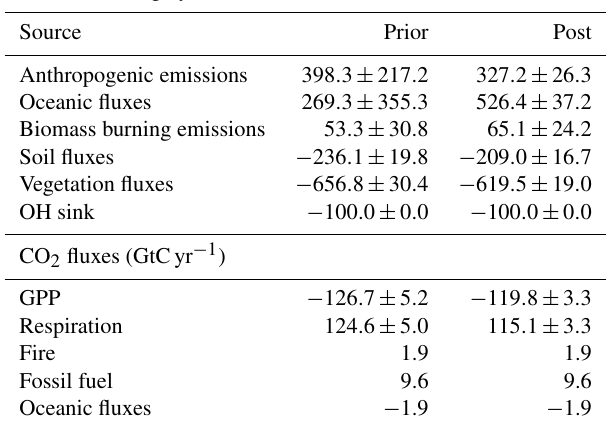
Table 5. Prior and posterior total fluxes and their associated 1 σ un- certainty as part of the COS (top) and the CO 2 (bottom) budgets. The mean magnitude of the different types of fluxes is given for the period 2009–2019. The vegetation sink is computed from the vegetation uptake (table on the right) using the LRU relationship described in Eq. (4). The components of the CO 2 and COS bud- gets, as written here, have been obtained by adding all the related optimized parameters (see Table 2 for a description of the parame- ters). The flux convention is positive upwards (from the surface to the atmosphere). For a given component, the associated uncertainty is the root mean square of the sum of all the posterior error covari- ance terms related to the component divided by the number of years (11